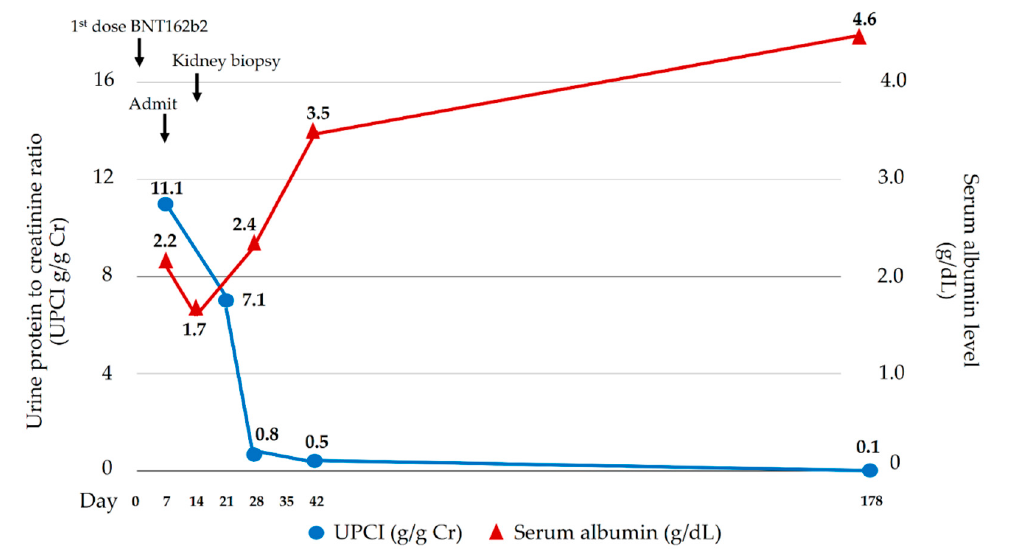
Figure 2. Clinical courses of nephrotic syndrome .